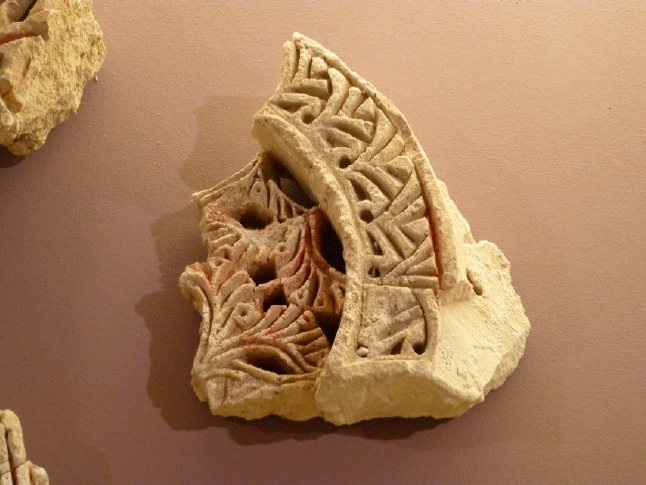
Figure 23. Window latticework fragment, Molina de Aragón Synagogue. Author’s photo.